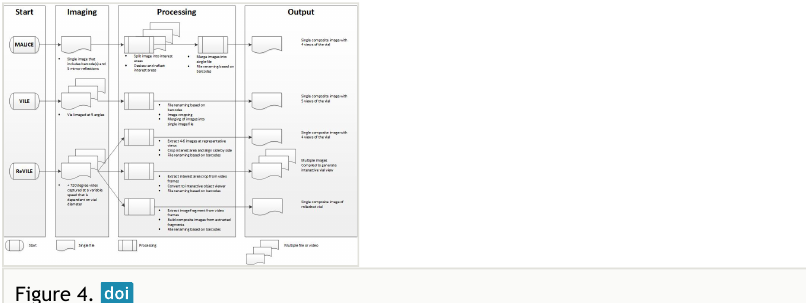
Illustrative workflow for the three vial digitisation approaches MALICE, VILE and